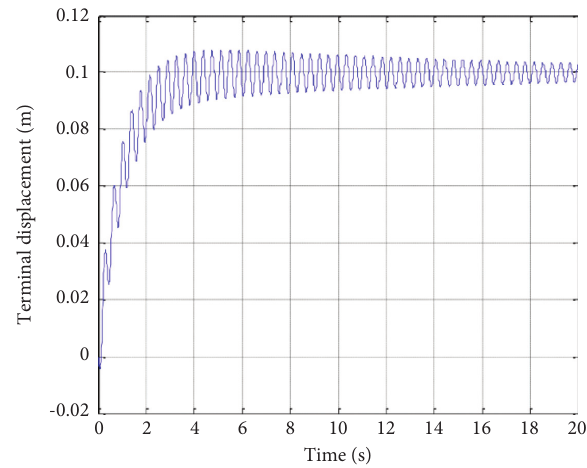
x with PD control.